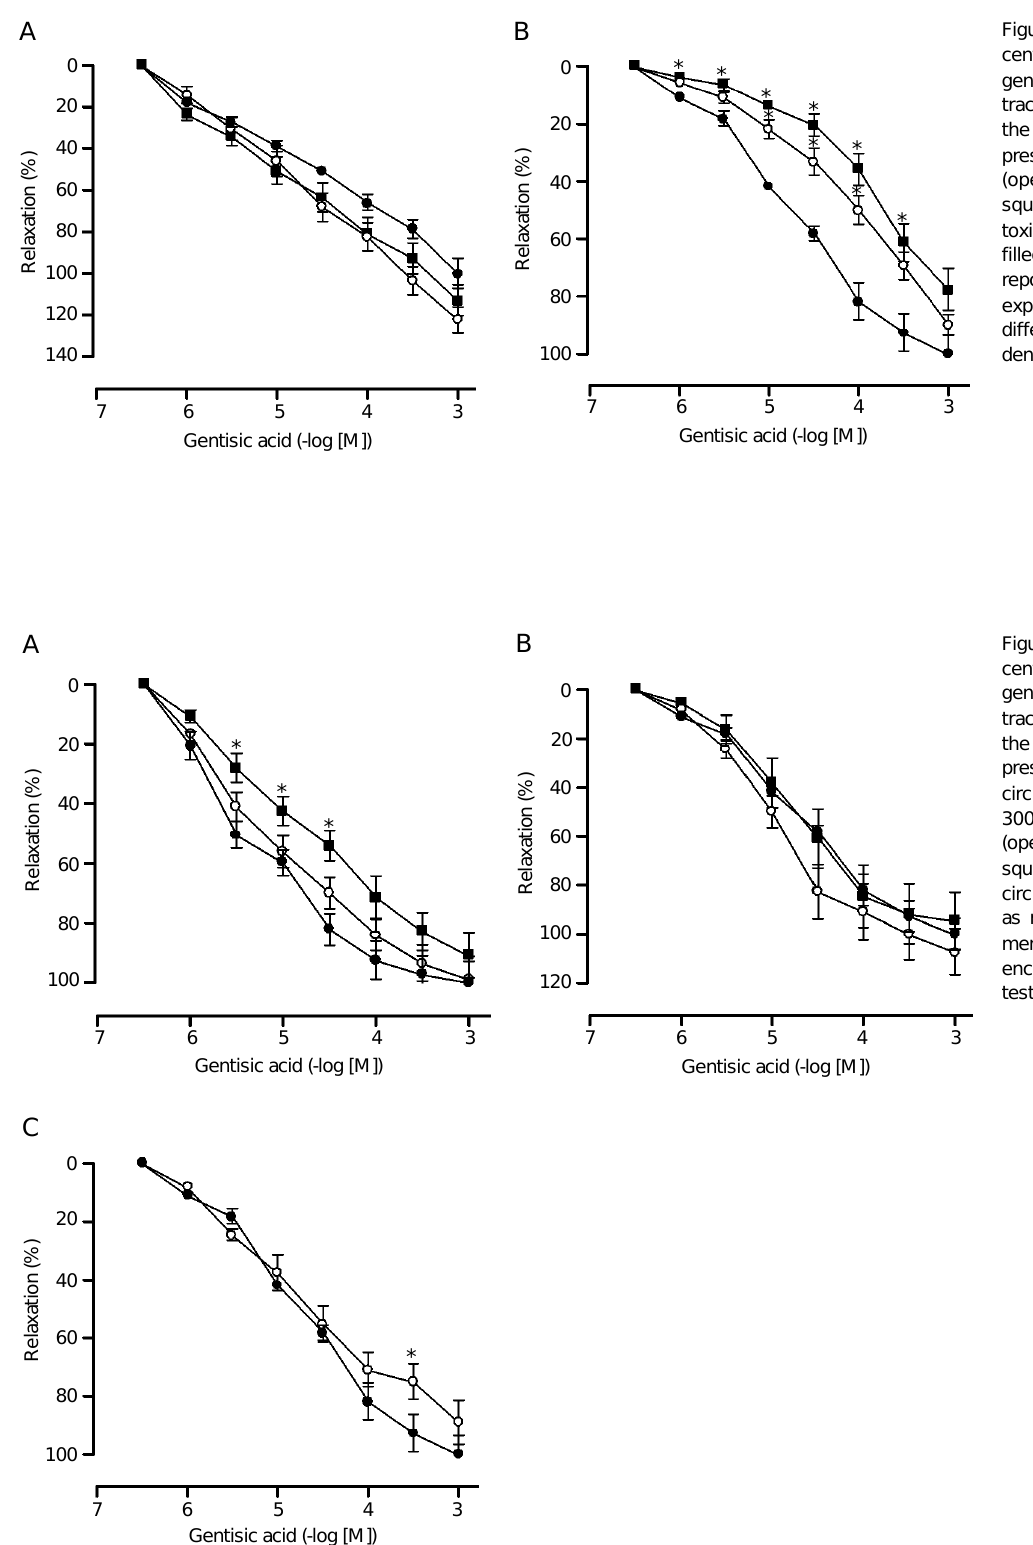
Figure 3 - Mean relaxant con- centration-response curves for gentisic acid in the guinea pig trachea without epithelium in the absence (filled circles) or presence of: A , glibenclamide (open circles, 1 µM or filled squares, 3 µM); B , charybdo- toxin (open circles, 0.1 µM or filled squares, 0.3 µM). Data are reported as means ± SEM of 6 experiments. *P<0.05 for the difference between points (Stu- dent t -test).